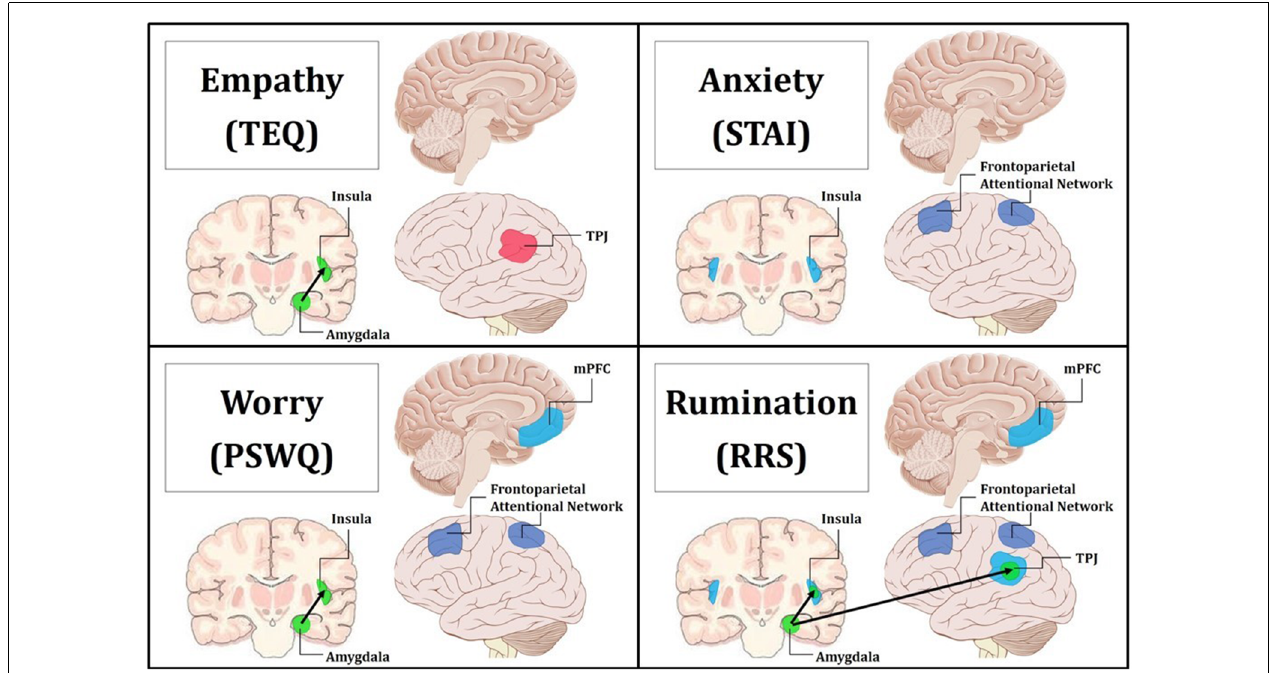
FIGURE 8 | Summary figure of neuroimaging findings related to each trait. Behaviorally and neurally, empathy shared direct relationships with worry and rumination. Additionally, anxiety exhibited behavioral relationships and common neural correlates with worry and rumination. Empathy was found to only share a significant indirect behavioral relationship with anxiety through worry, and this is reflected in the convergent neural correlates of worry and rumination. Pink indicates increased regional activations for F > N. Blue indicates increased regional activations for N > F. Green with black arrows denotes increased FC for N > F. Purple represents decreased top-down attentional control for F > N when comparing the Upper > Lower halves of questionnaires. Top Left: empathy was positively related to increased activation in the left TPJ for F > N, and increased FC between the left amygdala and insula for N > F. Top Right: anxiety was related to increased activations in bilateral insula for N > F, and decreased activations in the frontoparietal attentional network for Upper > Lower. Bottom Left: worry was related to increased activation in the mPFC for N > F, increased FC between the left amygdala and insula for N > F, and decreased activations in the frontoparietal attentional network for Upper > Lower. Bottom Right: rumination was related to increased activation in the mPFC, bilateral insula and bilateral TPJ for N > F, increased FC between the left amygdala and insula as well as the left amygdala and TPJ for N > F, and decreased activations in the frontoparietal attentional network for Upper >